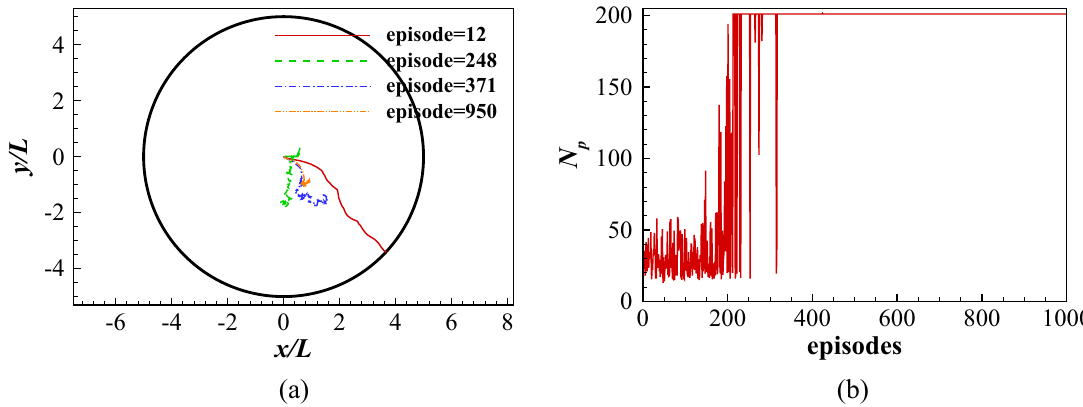
Figure 12. Rheotaxis: ( a ) the traces of the center of the mass during different learning stages, and ( b ) the total number of periods the fish maintains in the swimming area for all episodes